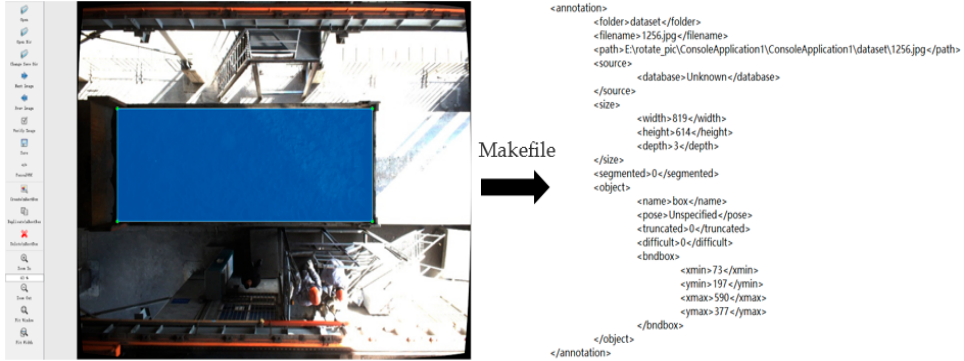
Figure 12. LabelImg data set annotation.